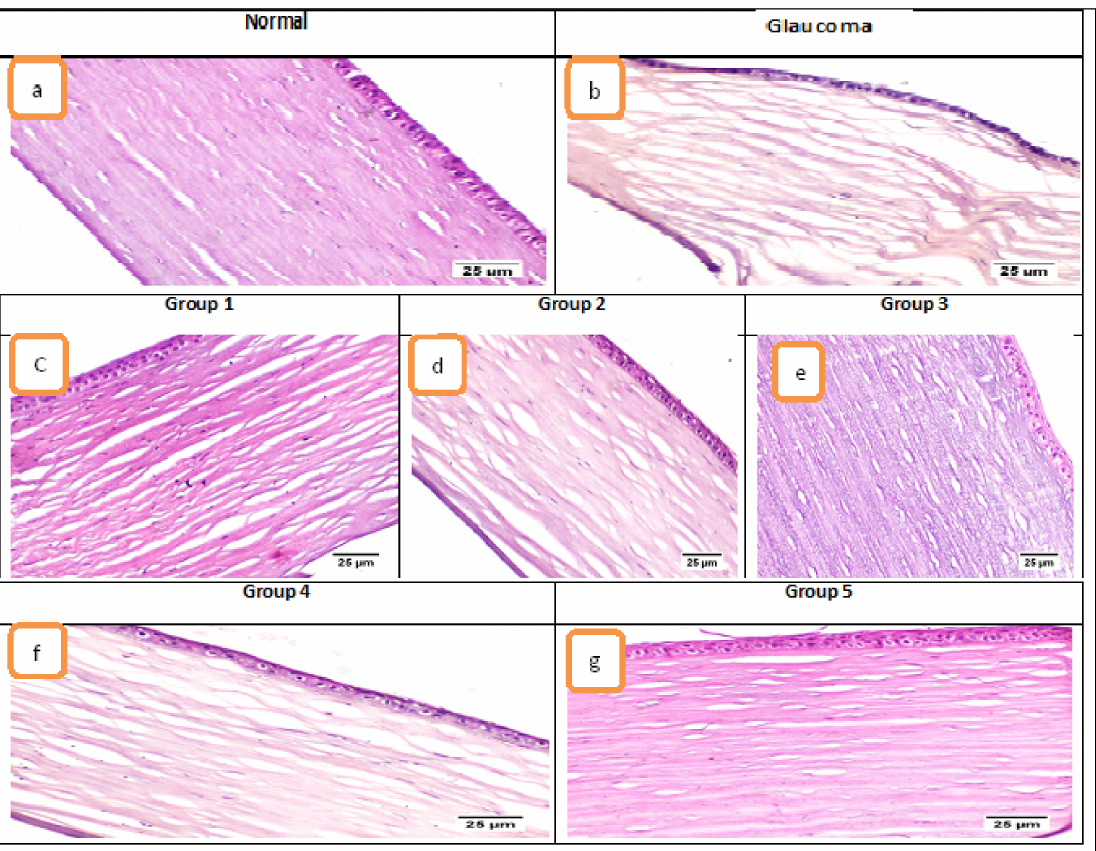
Figure 5. Photomicrographs of the cornea (H&E). Where ( a ) normal group showed histologically normal cornea, ( b ) glaucoma group showed marked corneal stromal edema, ( c ) Group 1 and ( d ) Group 2 showed mild edema, ( e ) Group 3 showed normal cornea, ( f ) Group 4 showed moderate edema, and ( g ) Group 5 showed normal